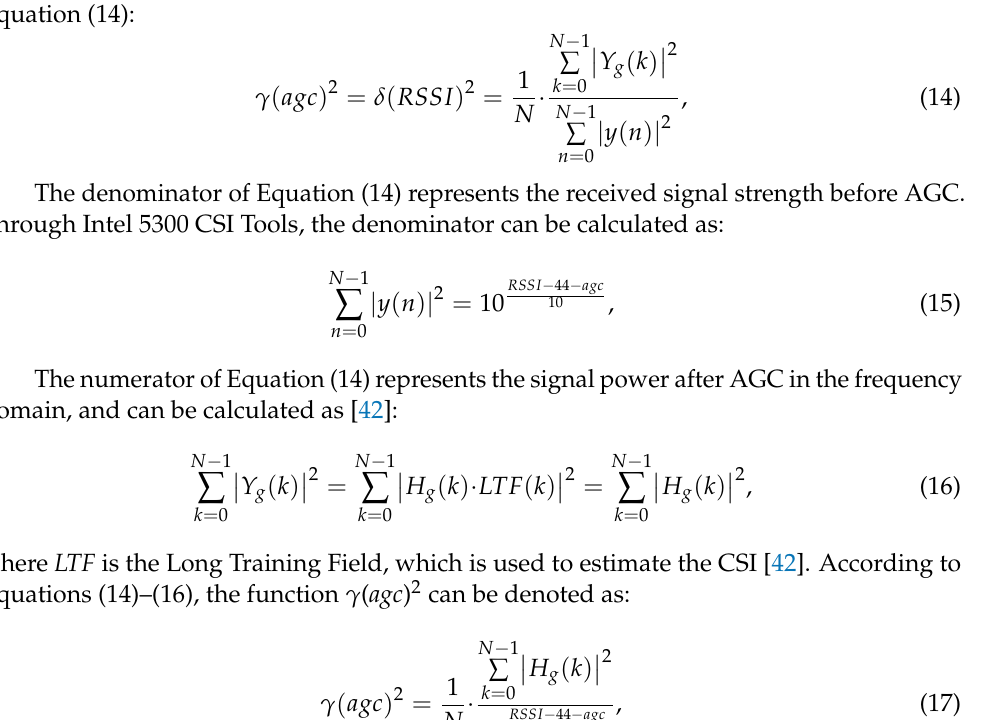
Figure 2. The relationship between